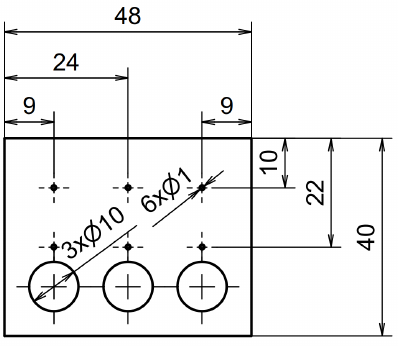
Fig. 2. Drawing of the heated block